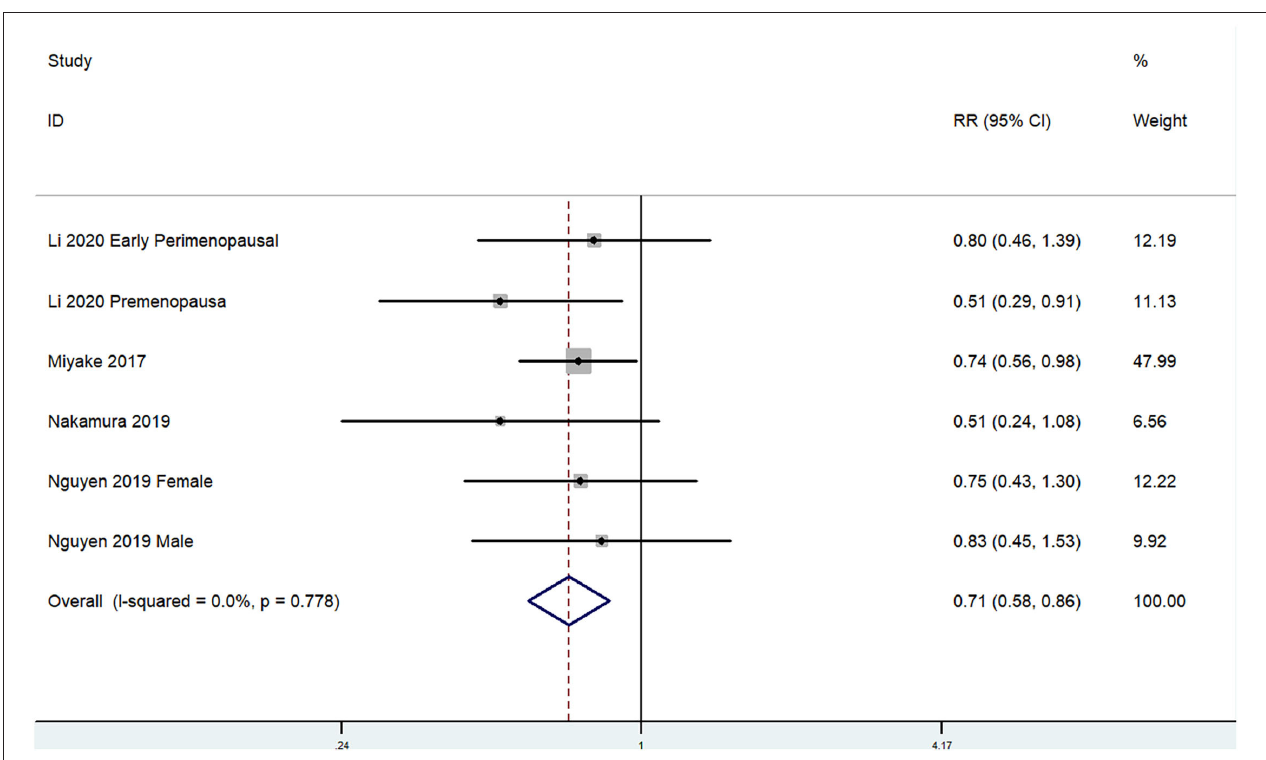
FIGURE 4 | Forest plot of meta-analysis: overall multi-variable adjusted RR of depression for the highest vs. lowest category of dietary manganese intake.